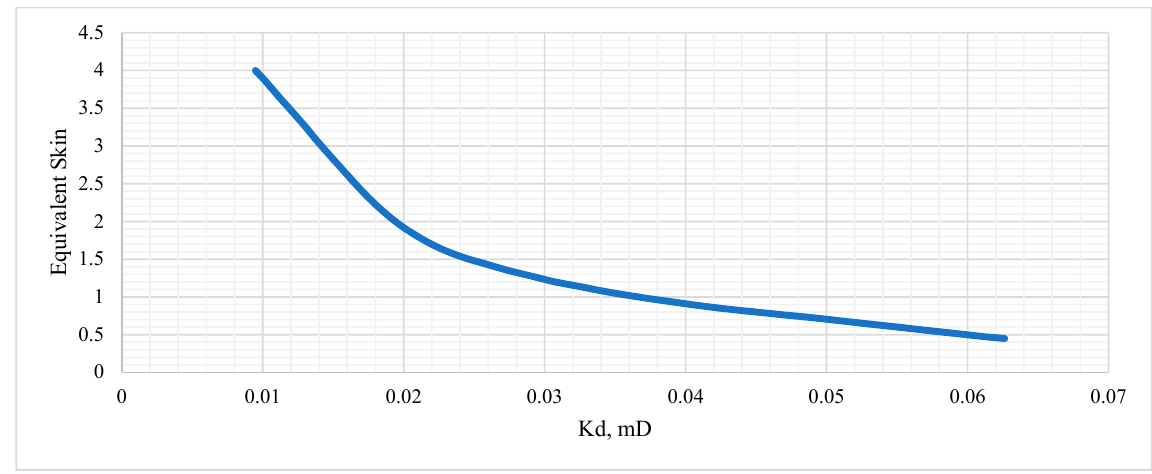
Figure 8. Equivalent skin factor versus damaged zone permeability.